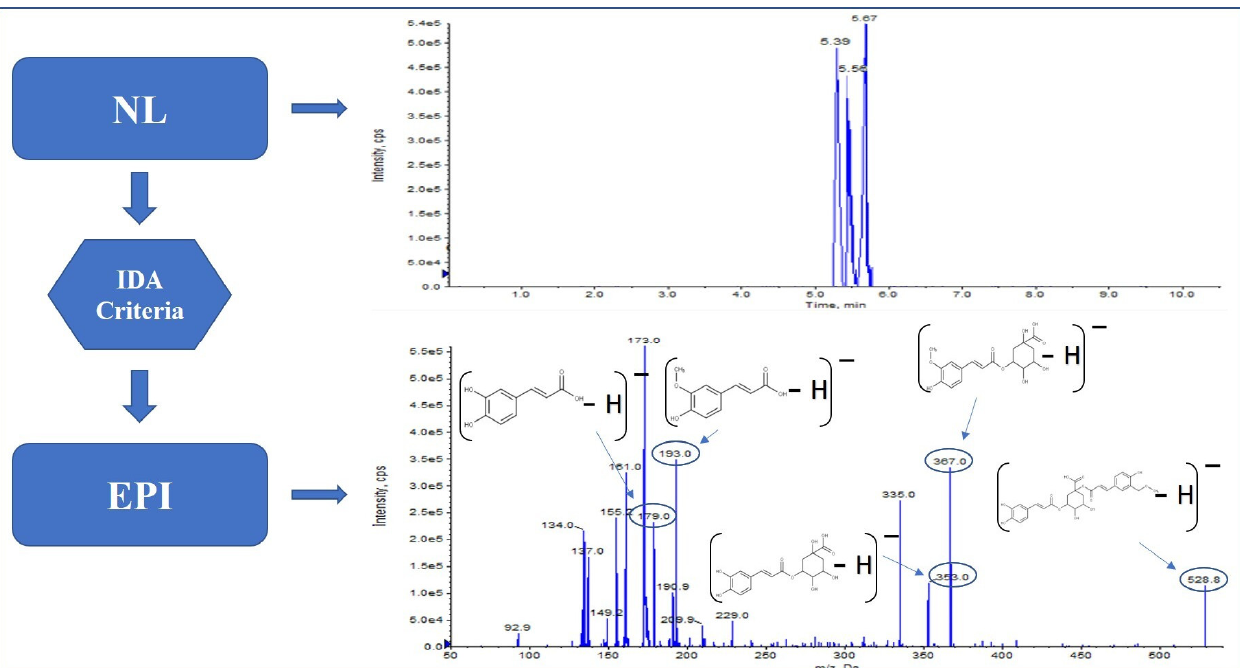
Figure 2. Feruloyl-5-caffeoylquinic acid fragmentation pattern in green coffee. With NL scans of 162 amu, the catechin-hexoside has been identified, with the EPI experiment showing the fragmentation pattern m / z 109, 125, 245 and 289, predominant in the coffee varieties [44].